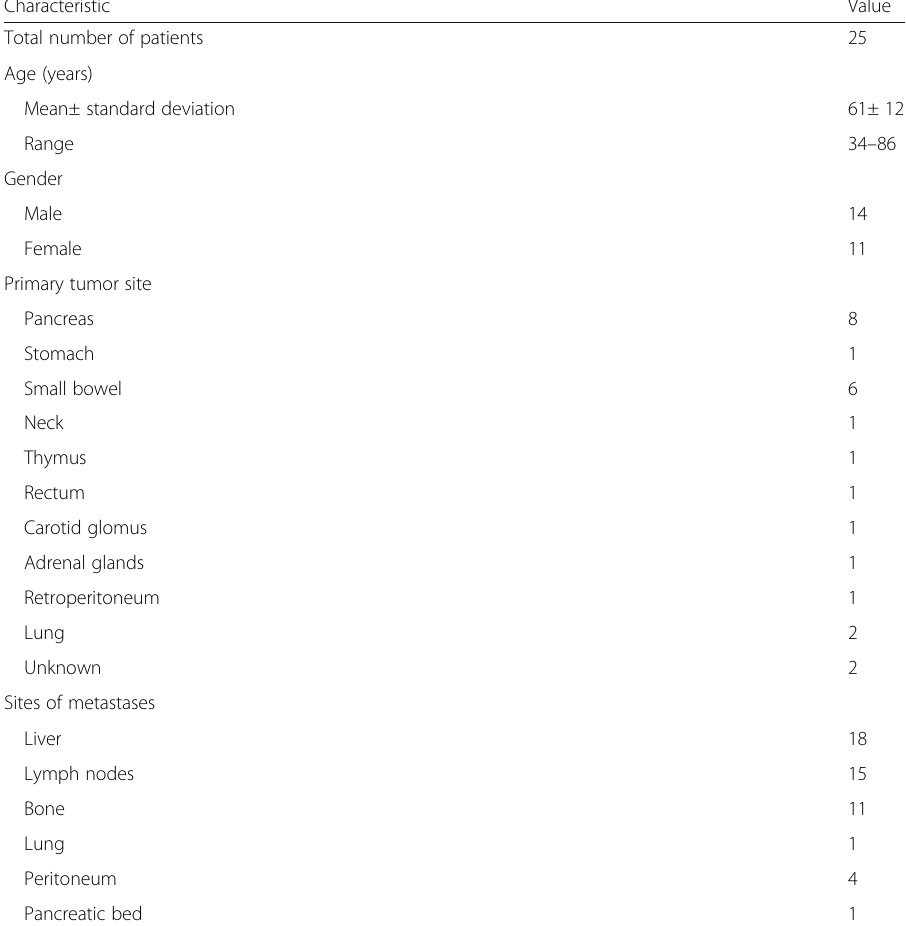
Table 1 Clinical